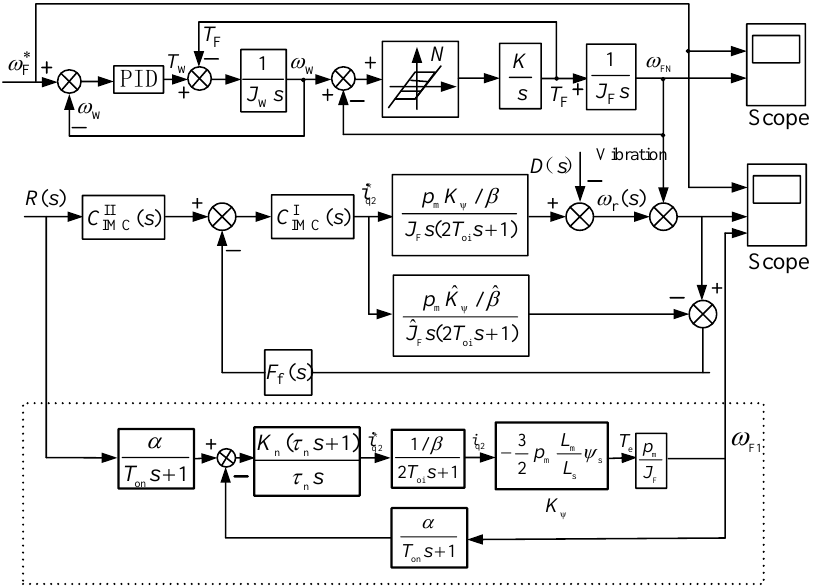
Figure 22. The experimental scheme of the generator speed control. * means the reference value.